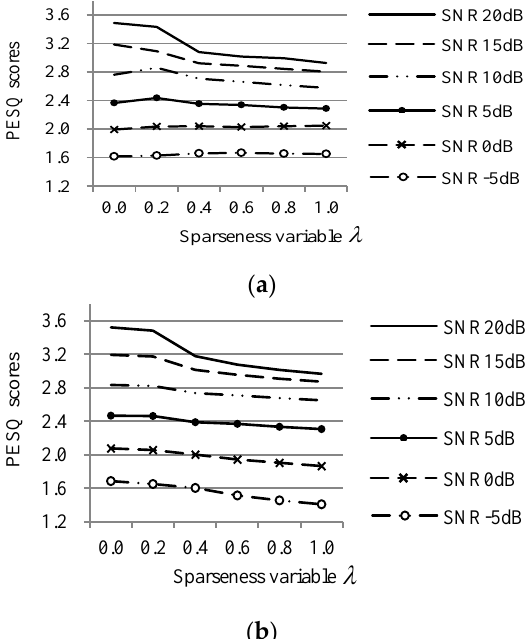
Figure 5. The comparison of perceptual evaluation of the speech quality (PESQ) scores for the proposed method for di ff erent sparseness control parameters, under ( a ) babble and ( b ) Gaussian noise